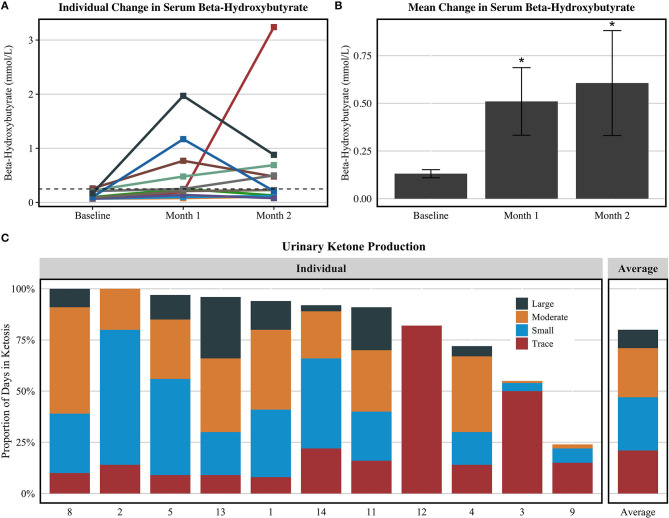
Urine acetoacetate and serum BHB values among compliant participants (n = 11). (A) Serum BHB values for each subject. (B) Mean serum BHB values ± standard error. (C) The proportion of days in which each participant's self-reported urine acetoacetate analysis revealed ketosis and depth of ketosis achieved. The figures exclude the one participant that completed the study procedures but did not record elevated ketone bodies at any point during the intervention. *P < 0.05 compared to baseline value via Dunn's test of multiple comparisons.